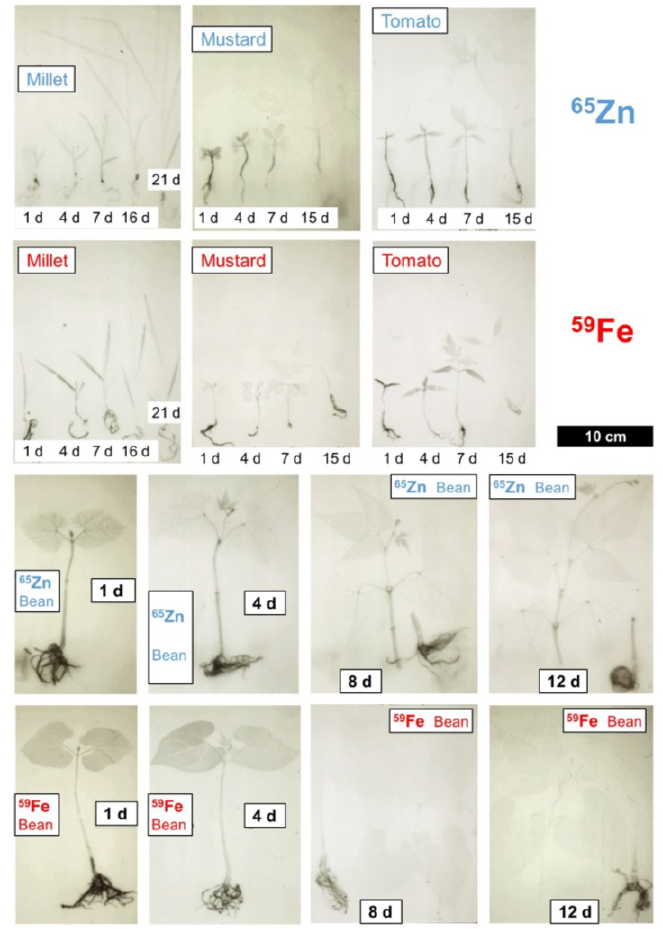
Figure 2. Xylem and phloem transport in the intact plant. Zn, Ni and Mn are readily transported via xylem to the shoot. Mn is essentially immobile in phloem, while Ni is rapidly redistributed to the youngest (expanding) plant parts and Zn is more slowly redistributed via the phloem (accumulation in meristems, but also well mobile in the